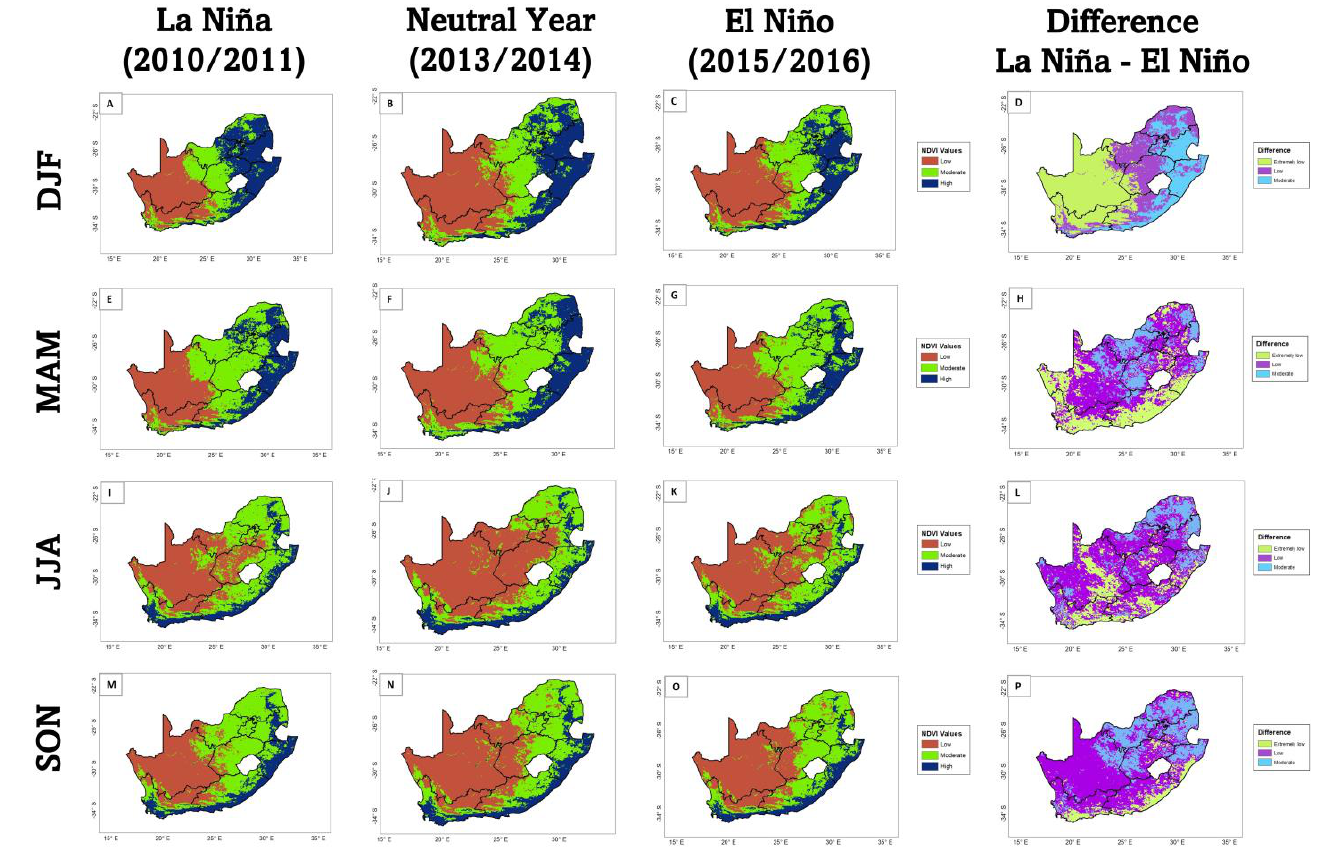
Figure 5. Seasonal mean spatial distribution of NDVI during the La Niña ( a , e , i , m ), neutral year ( b , f , j , n ) and El Niño periods ( c , g , k , o ) and the difference between the two extremes ( d , h , l , p ). The following discussion is limited to the interior and eastern parts of South Africa.